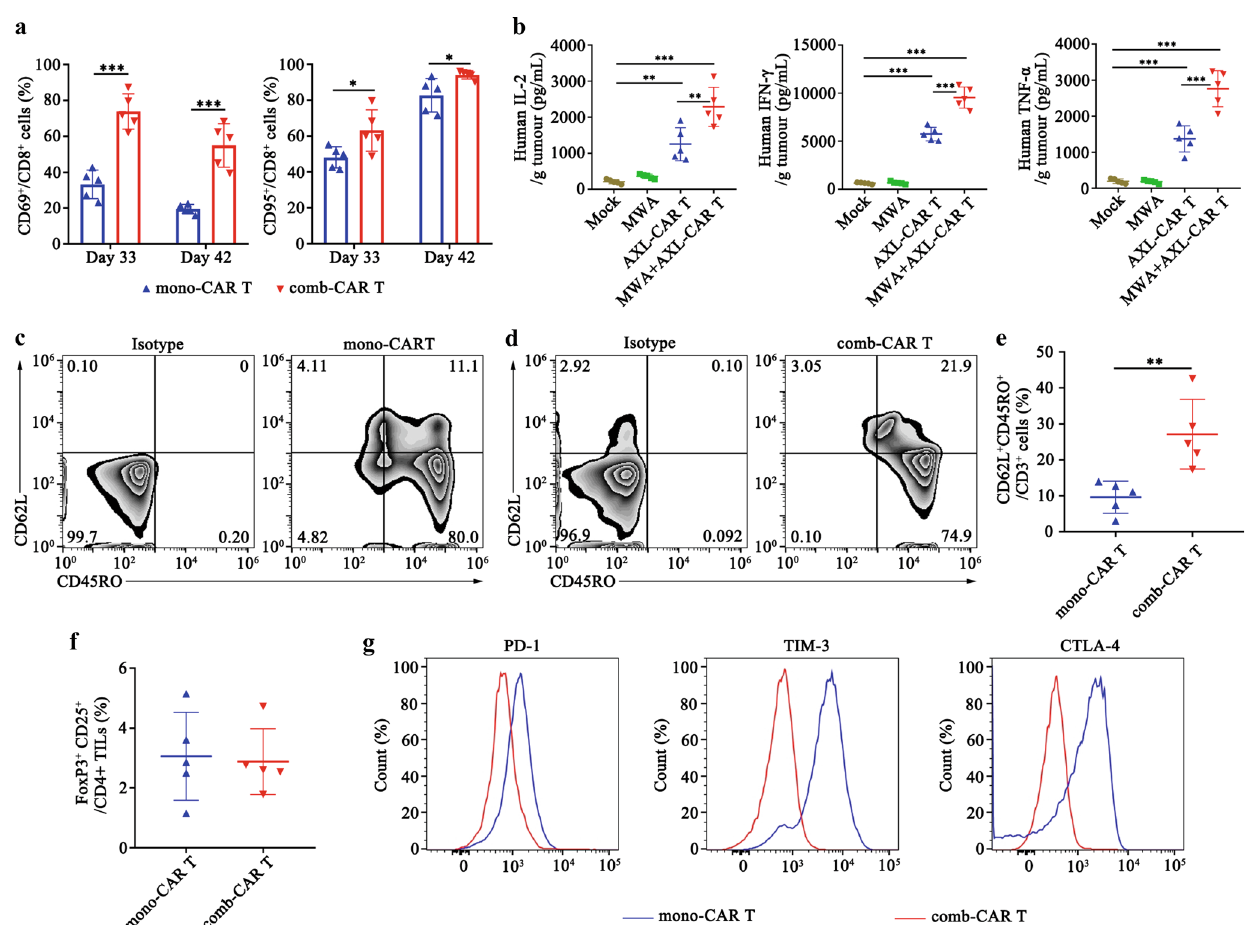
Fig. 6 | MWA enhances activation and memory phenotype of tumour- in fi ltratingAXL-CARTcellsandreducestheirexhaustioninPDXbearingmice. a ExpressionofactivationmarkersCD69andCD95intumour-in fi ltratingCD8 + CAR T cells on day 33 and 42 analysed by fl ow cytometry. Data were analysed by two- sided unpaired t -test (CD69: day 33: mono-CAR T vs comb-CAR T p <0.0001. day 42: mono-CAR T vs comb-CAR T p =0.0002. CD95: mono-CAR T vs comb-CAR T p =0.03). b Cytokine pro fi le of bulk tumours on day 42. Cytokines in the homo- genatesupernatantwereanalysedbyELISA.Datawereanalysedbyone-wayANOVA with Tukey ’ s multiple comparisons test (IL-2: Mock/MWA vs MWA+AXL-CAR T p <0.0001, AXL-CAR T vs MWA+AXL-CAR T p =0.002. IFN- γ / TNF- α : Mock/MWA/